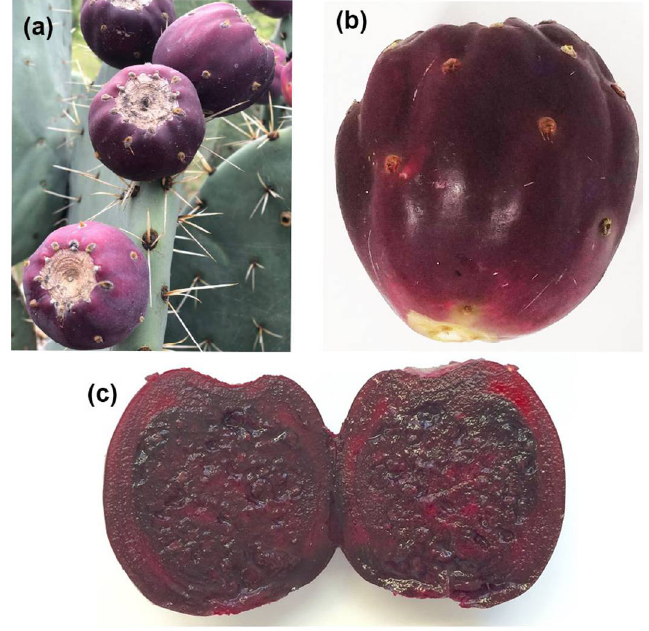
Figure 1. ( a ) Cladodes of Opuntia robusta in the wild where they were collected, with some fruits (prickly pears). The cladodes are circular in shape and bluish in color. ( b , c ) Ripe fruits reach a size of 7 to 11 cm.